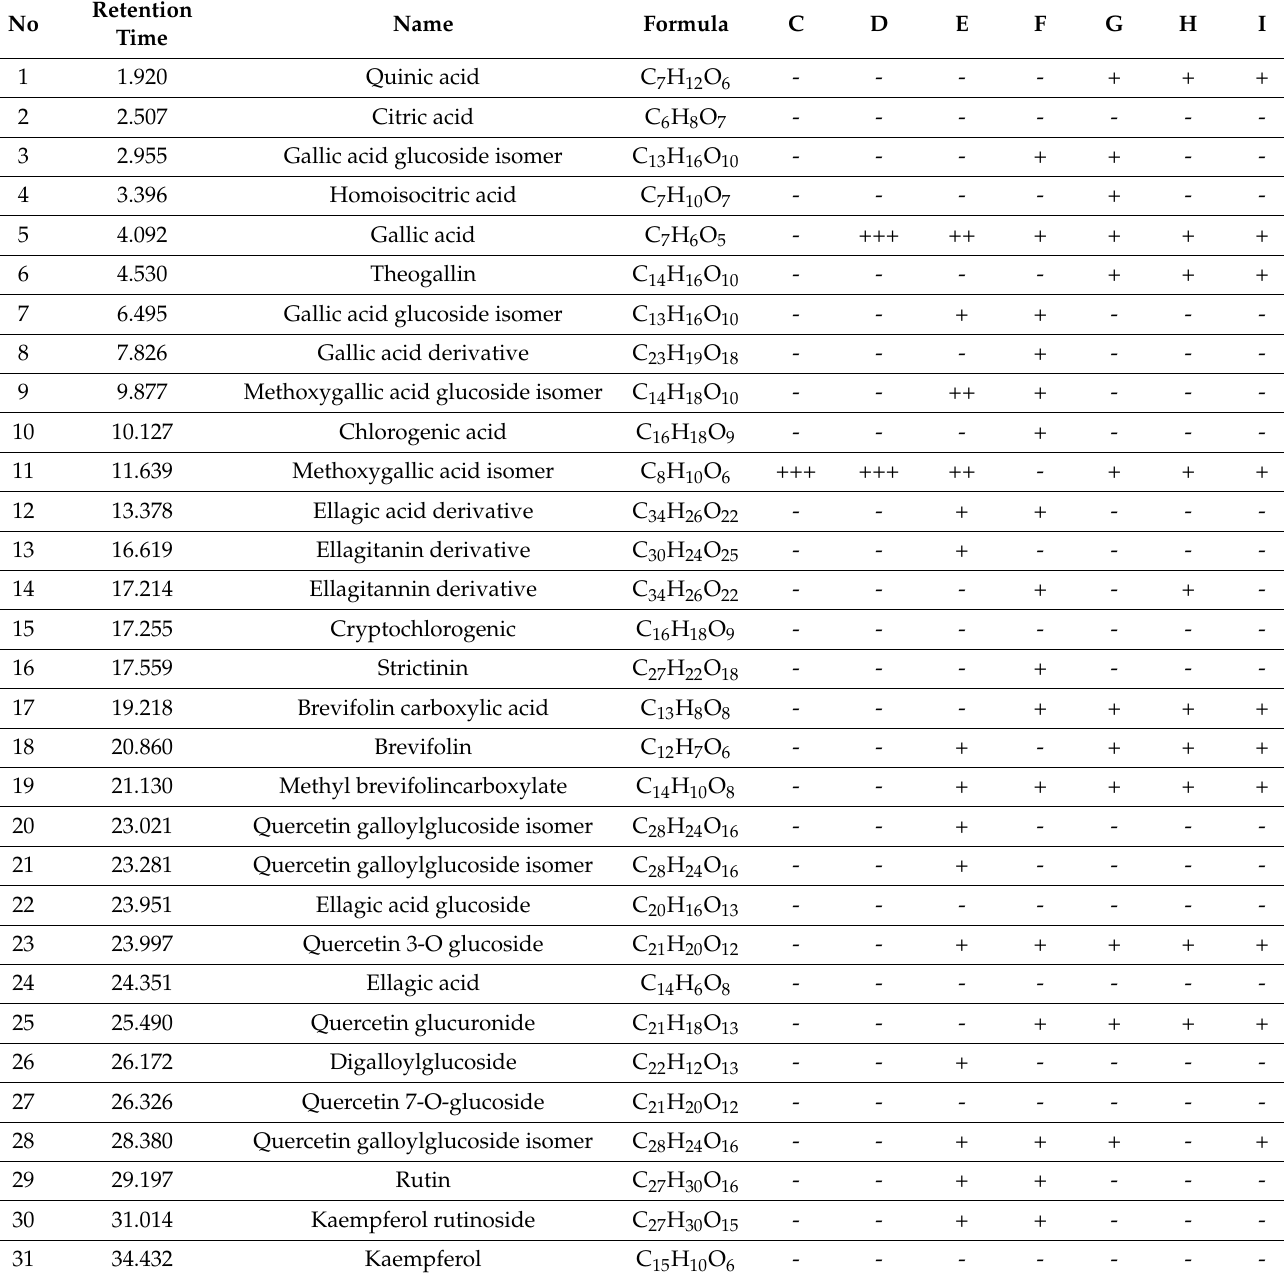
compound was estimated as high (+++), moderate (++), and low (+) and indicated in Table 4. The most abundant compounds in all fractions were gallic acid and its derivatives (methoxygallic acid isomer and methoxygallic acid glucoside isomer). Fractions E–I con- tained also quercetin and brevifolin derivatives, whereas these compounds were absent in fractions C and D. Table 4. Comparison of the chemical composition of the fractions C-I obtained from extract R3 after HPLC/ESI-QTOF-MS analysis in negative ion mode; the relative content of identified compounds was indicated as high (+++), moderate (++), and low (+) based on the surface areas of the peaks in corresponding chromatograms (Figure